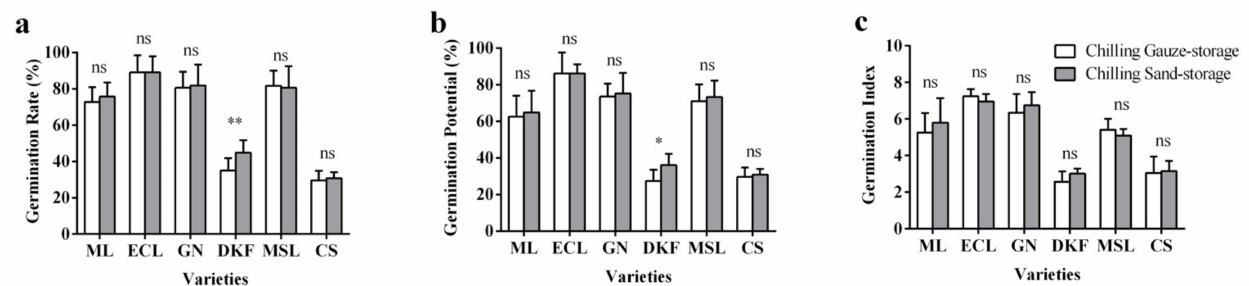
Figure 1. Effect of stratification treatments on seed germination characteristics of six tested varieties: ( a ) influence of stratification treatments on seed germination rate of tested varieties, ( b ) influence of stratification treatments on seed germination potential of tested varieties, and ( c ) influence of stratification treatments on seed germination index of tested varieties. Data in this figure were tested by Student’s t test; * p < 0.05 and ** p < 0.01 represent significant differences between treatments, and ns indicates not significant. ML, ECL, GN, DKF, MSL, and CS represent varieties of Meili, Ecolly, Garanior, Dunkelfelder, Marselan, and Cabernet Sauvignon. It can be observed in Figure 2 that GA 3 , 6-BA, CPUU, and HAc improved seed the highest, especially for Ecolly, with seed germination rate, potential, and index of 95.72%, 94.29%, and 9.64% respectively.